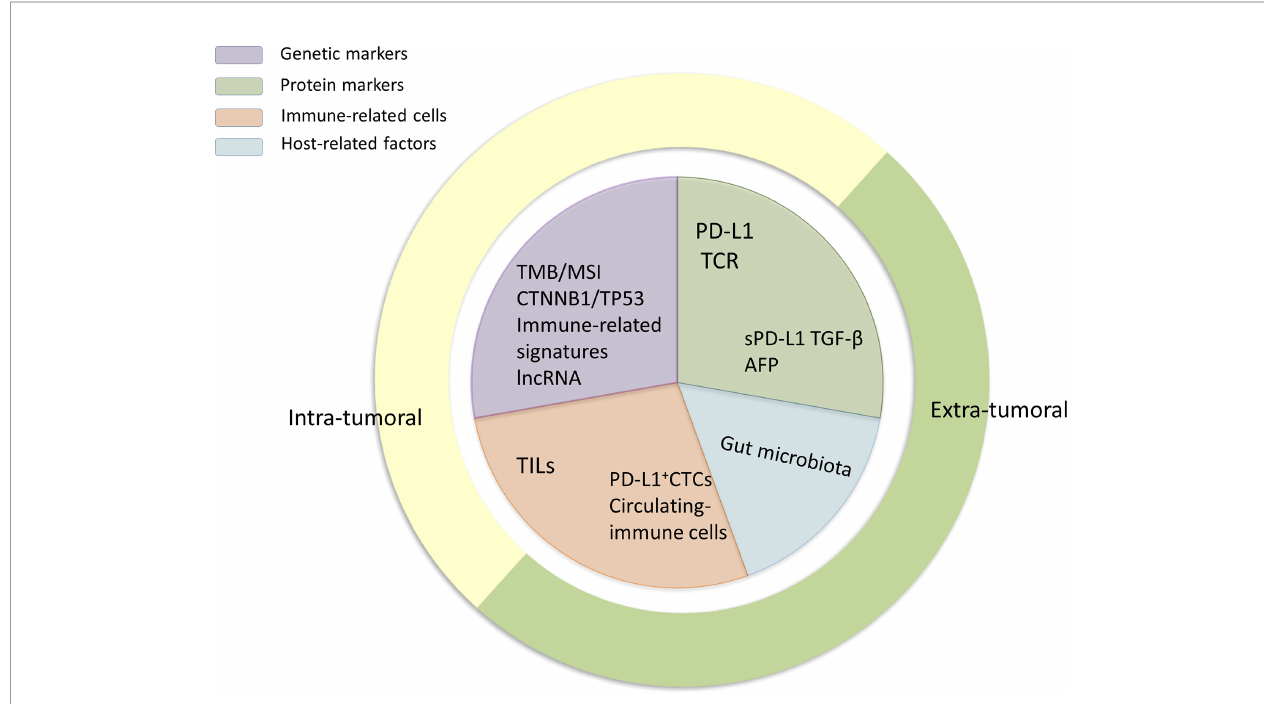
FIGURE 1 | The classi fi cation of biomarkers. The biomarkers introduced in this review can be divided into protein markers, gene markers, immune-related cells, and host-related cells. Moreover, according to their localization in vivo , they can be further subdivided into intratumoral and extratumoral biomarkers as they are detected using different